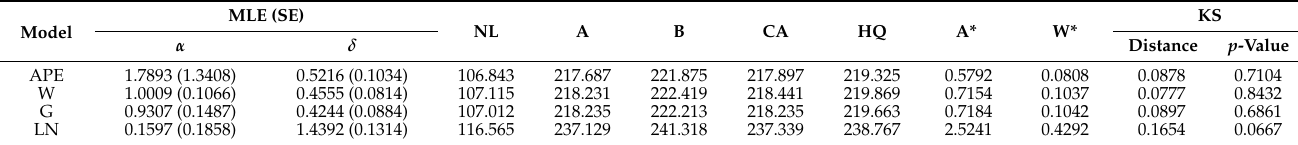
Table 3. Summary fit of the APE distribution and other competing models under electrical appliances